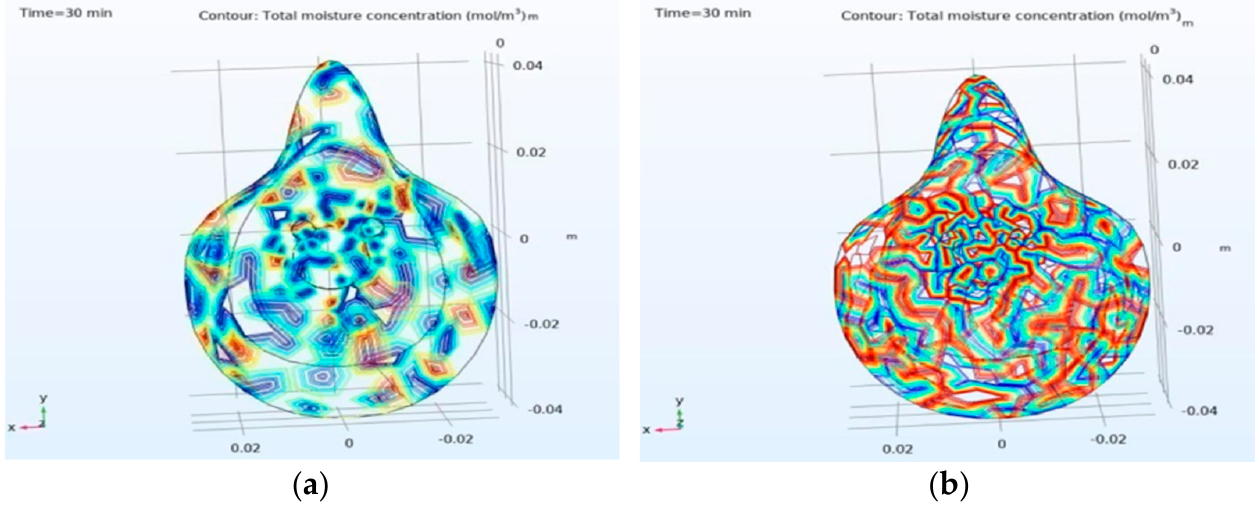
Figure 5. Total moisture concentration of the mask: ( a ) inner layer is 0.48 mol/m 3 ; ( b ) outer layer is 5.47 mol/m 3 .